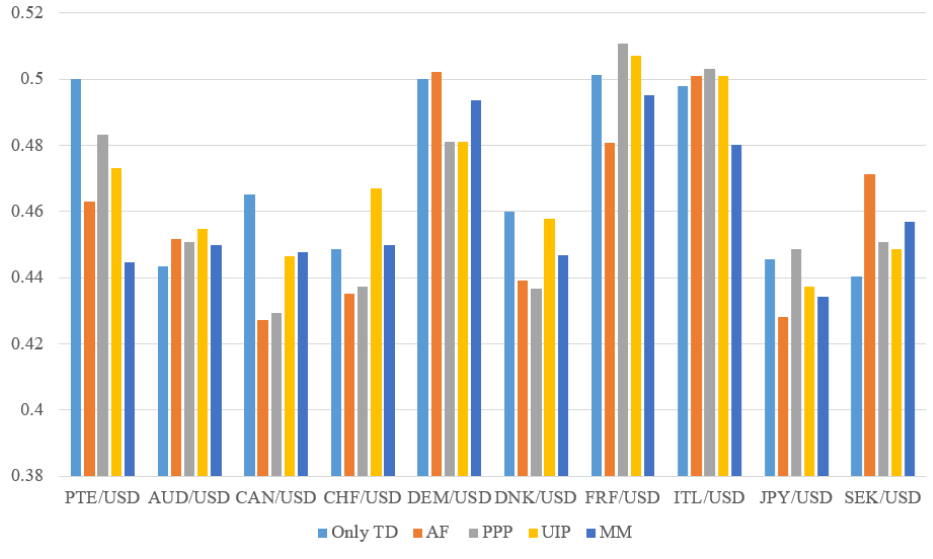
Figure 1. Error rates—every set of fundamentals vs. only